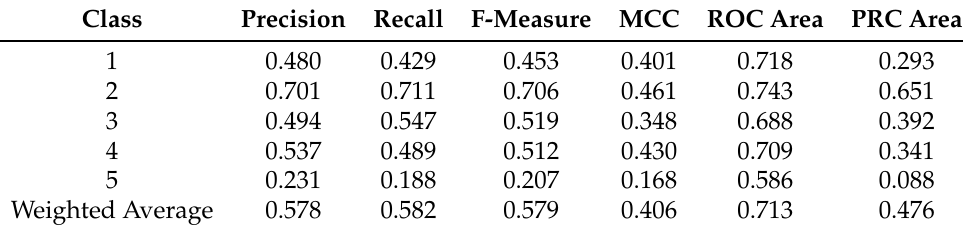
Table 6. KNN accuracy details.